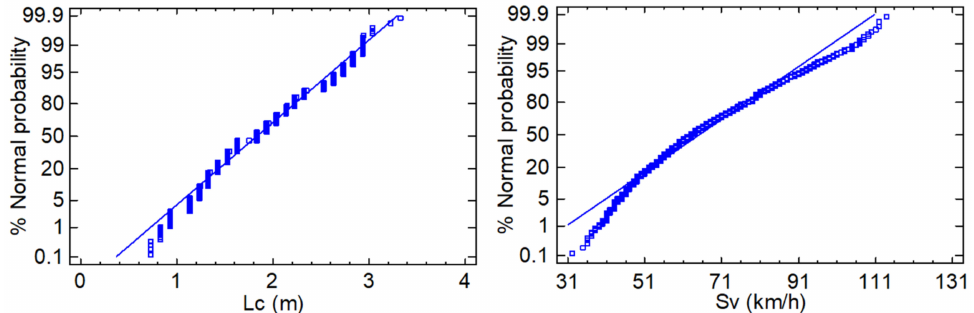
Figure 4. Normal probability plot for observed lateral clearance and overtaking vehicle